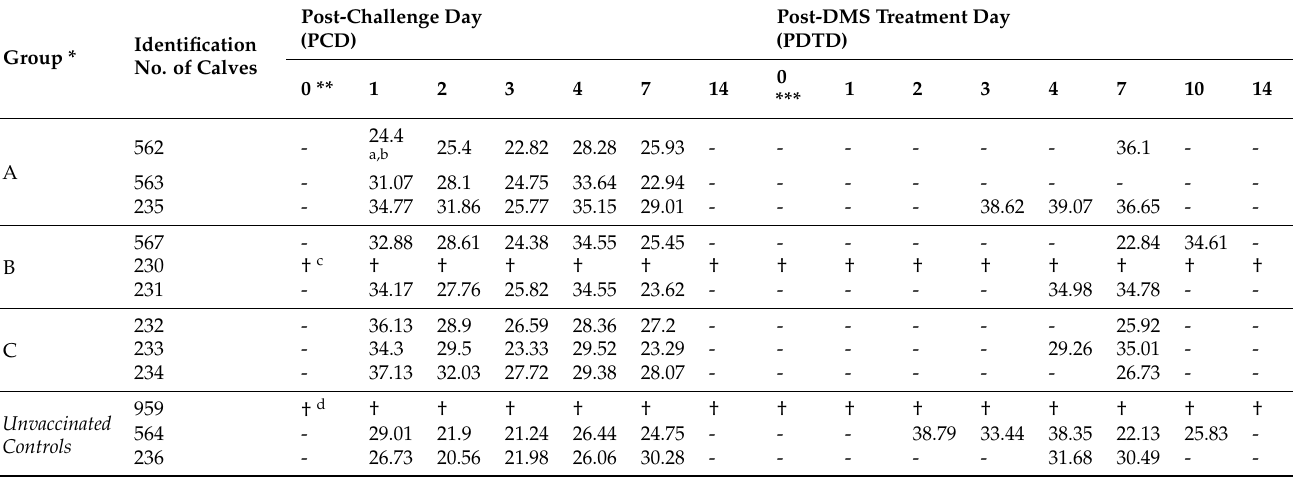
Table 3. Results of BoHV-1 detection by gB real-time PCR of calves immunized with different BoHV-1 marker vaccines, challenge infected with virulent strain of BoHV-1, and treated with